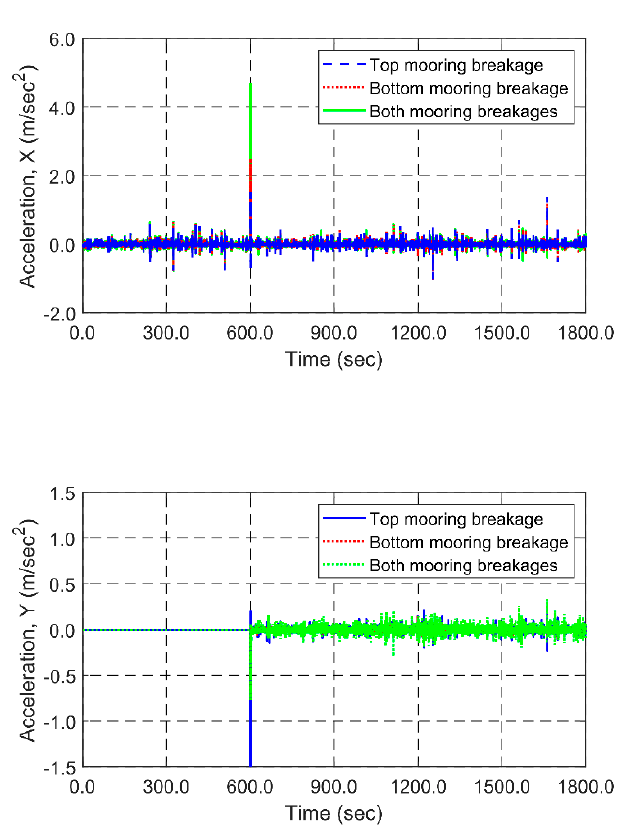
Figure 17. Time histories of X ( top ) and Y ( bottom ) directional accelerations of the net assembly in the middle location (Y = 0 m) as mooring lines at Y = − 50 m are broken after 600 s ( H s = 2.0 m, T p = 7.0 s, current velocity = 0.6 m/s). Table 3. Key monitoring parameters in different mooring-line-breakage scenarios (TEN = tension of top mooring line, DX = surge motion of location buoy in the middle location of the net assembly, AX = X-directional acceleration in the middle location of the net assembly, AY = Y-directional acceleration in the middle location of the net assembly, TOP = top mooring line, and BOT = bottom mooring line).